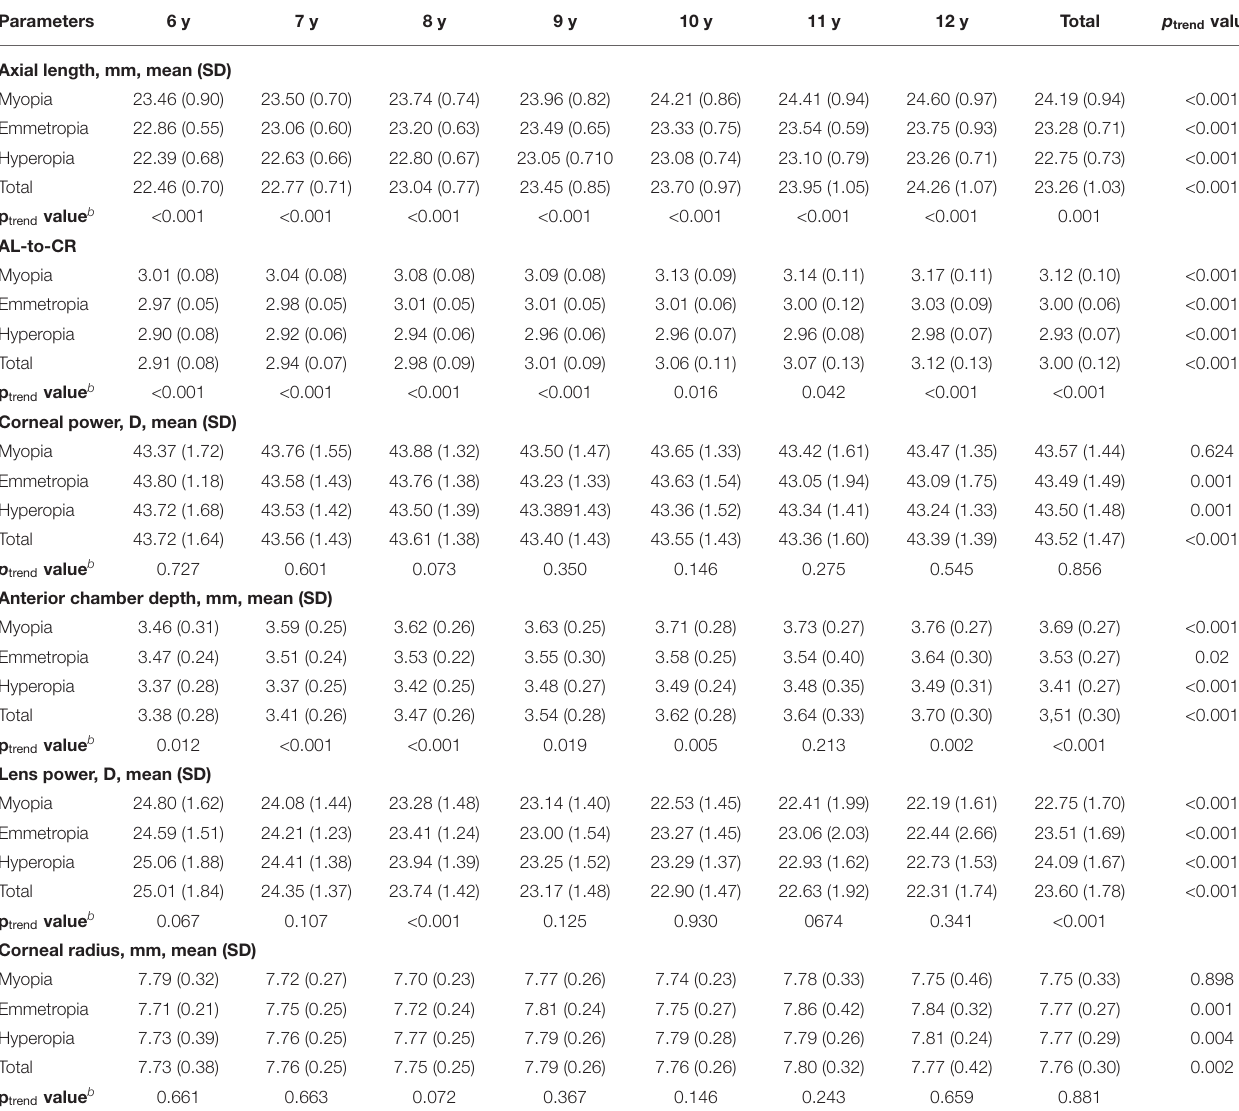
TABLE 3 | Distribution of the biometry parameters among different refraction error groups in 6- to 12 years old children, Beijing.